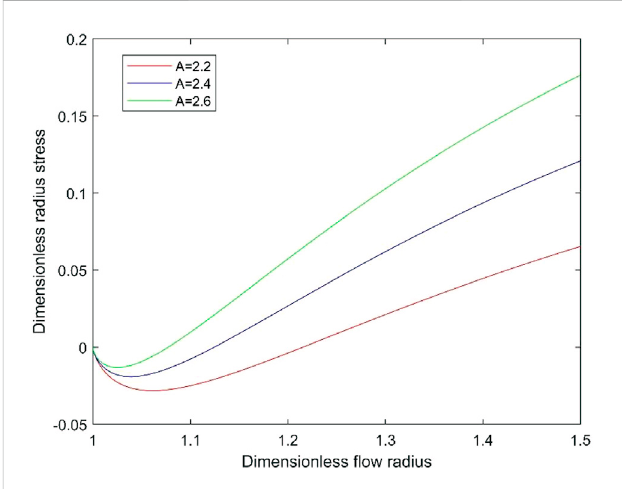
FIGURE 3 The effective radial stress distribution the acceleration fl ow for various